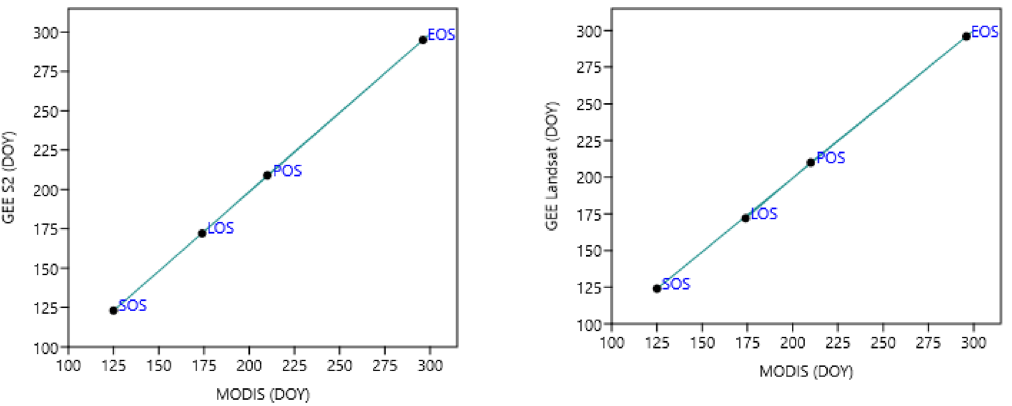
Figure 5. Comparison of Start of Season (SOS) and End of Season (EOS) dates computed, respectively, from Sentinel-2 and Landsat retrieved in R with the greenbrown package and from the GEE